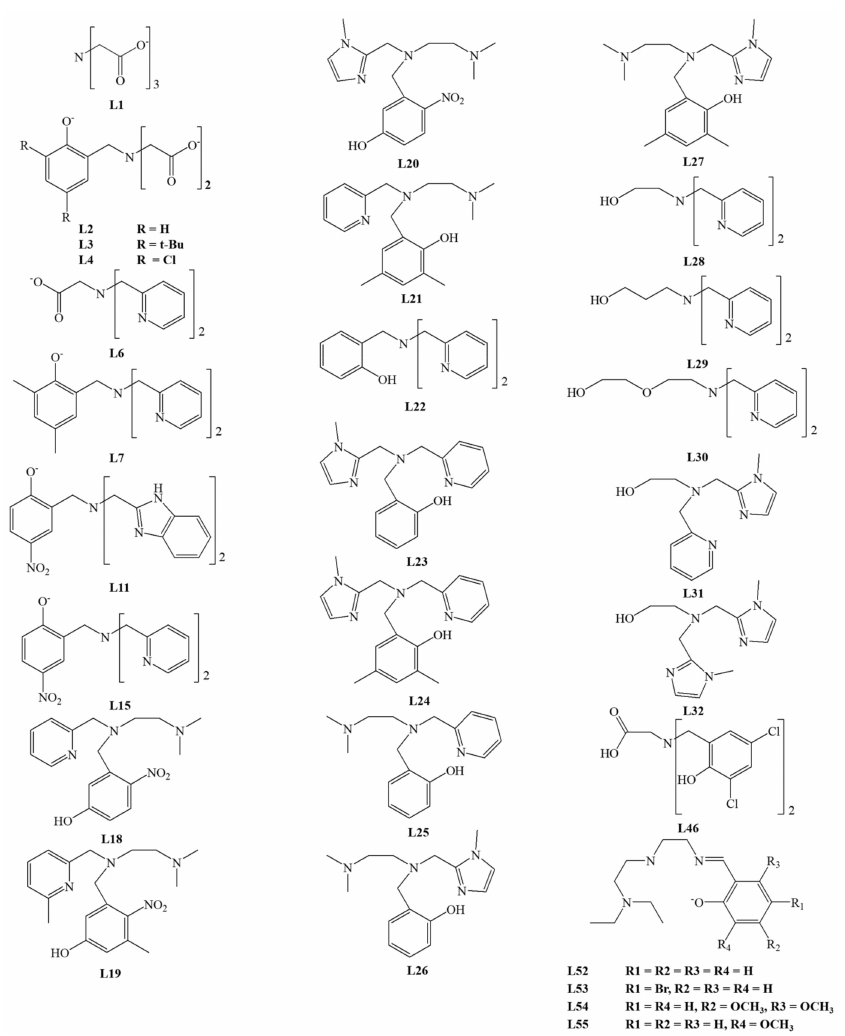
Figure 7. Tetradentate N 3 O and NO 3 donor ligands.